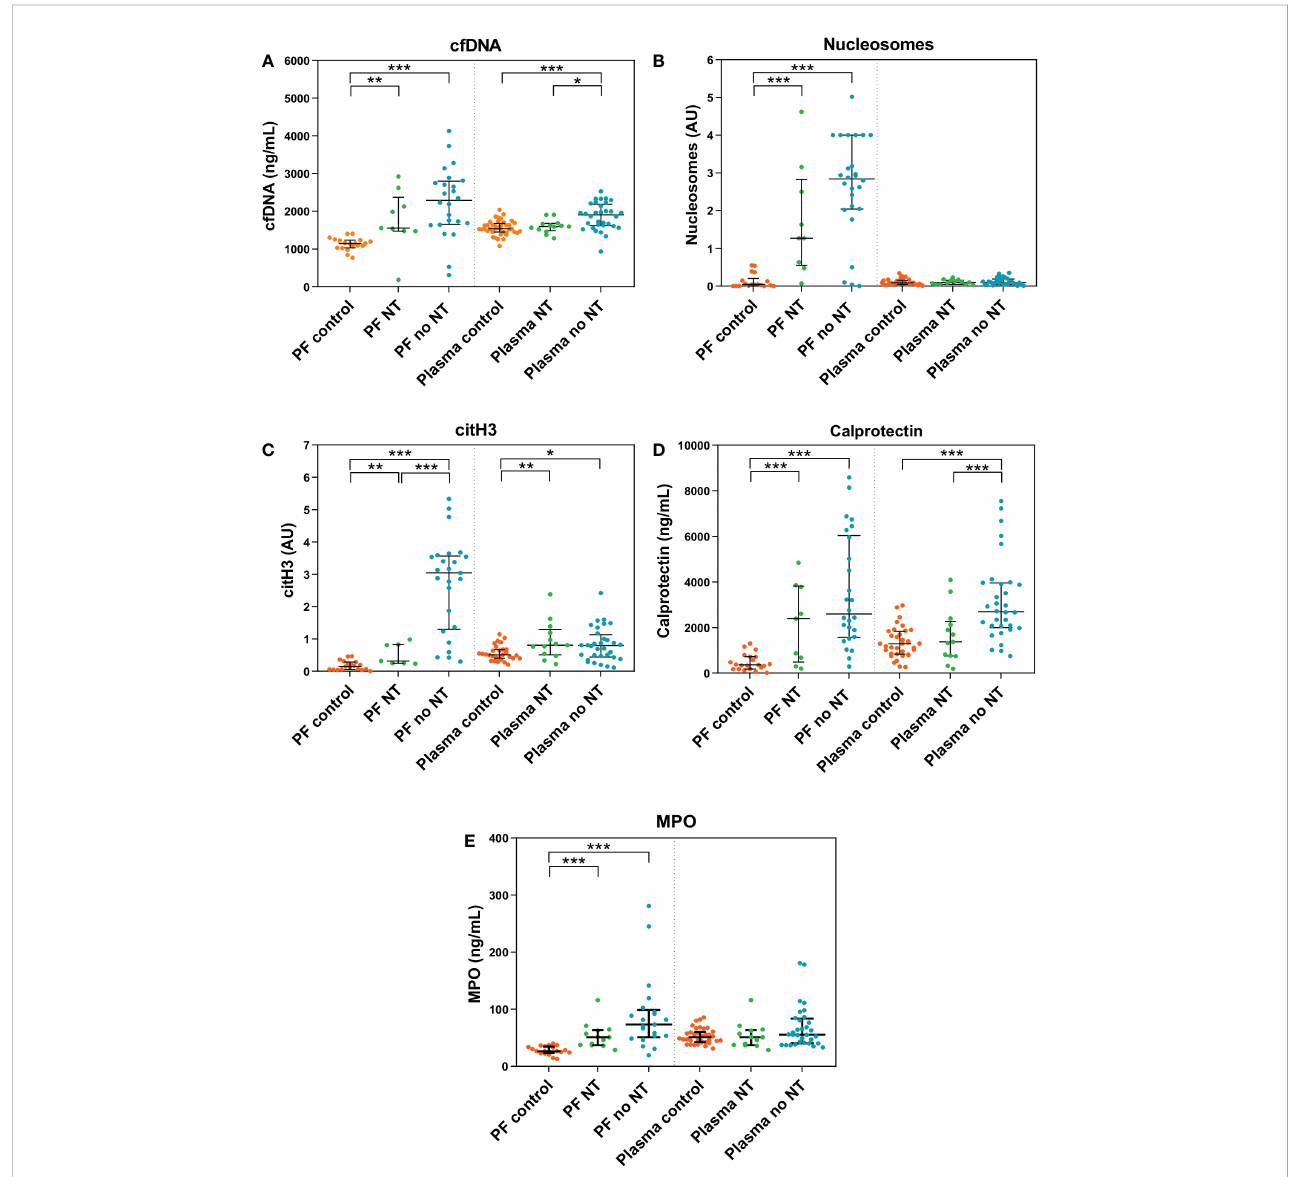
FIGURE 4 NETosis biomarkers in peritoneal fl uid (PF) and plasma samples of patients with high-grade serous ovarian cancer (HGSOC) without neoadjuvant treatment (NT) (n=9 and n=13, respectively), with NT (n=26 and n=32, respectively) and control women (n=21 and n=40, respectively). (A) cell-free DNA (cfDNA). (B) Nucleosomes. (C) citrullinated histone 3 (citH3). (D) Calprotectin. (E) Myeloperoxidase (MPO). Median values and interquartile ranges for NETosis biomarkers in each group are listed in Supplementary Table S5. AU, arbitrary units. *** p < 0.001; ** p < 0.01; * p < 0.05; Mann-Whitney U